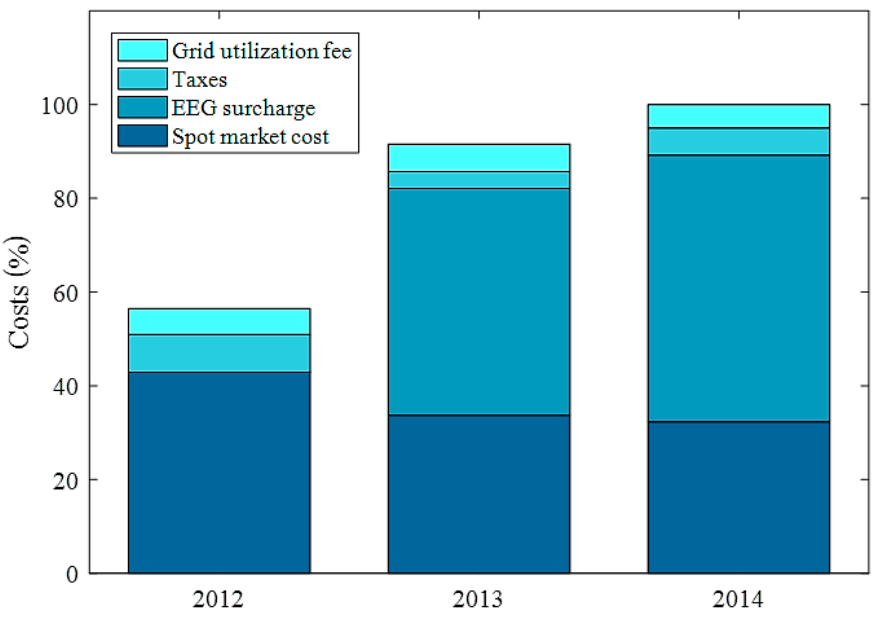
Figure 5. Cost components for electricity procurement by year in relation to the reference cost for 2014.